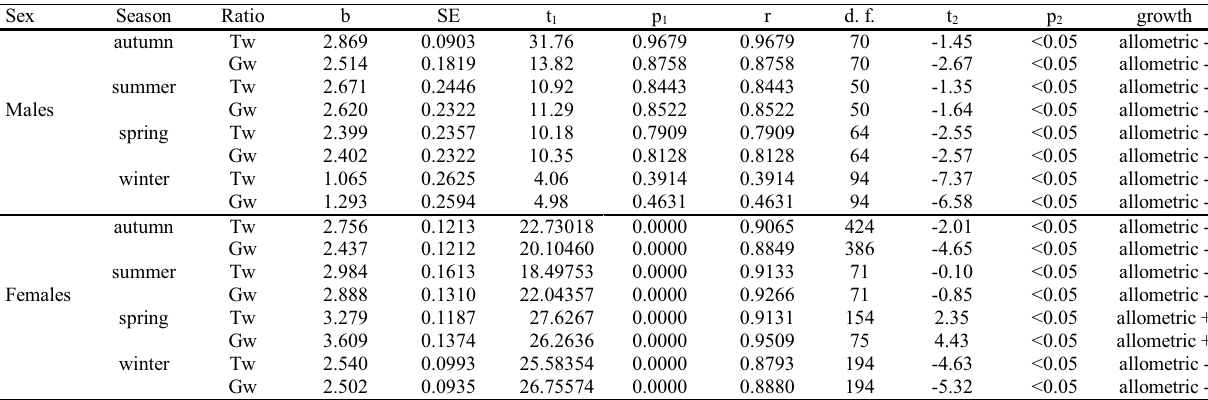
=t-test value of the regression and p 1 ) and the nature of growth according to b. 2